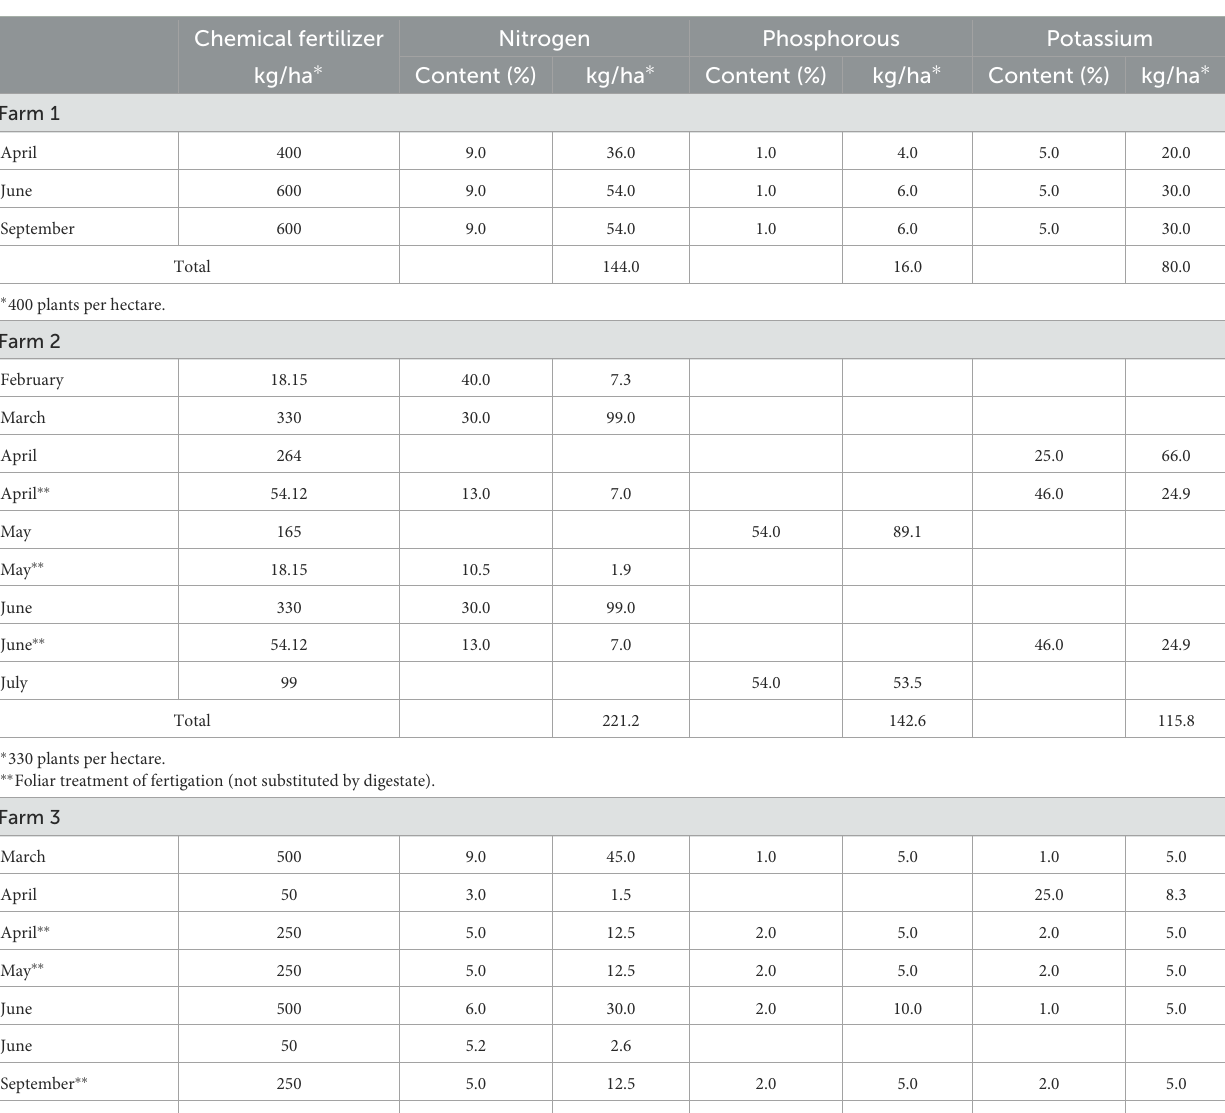
TABLE 2 Fertigation plans with traditional chemical